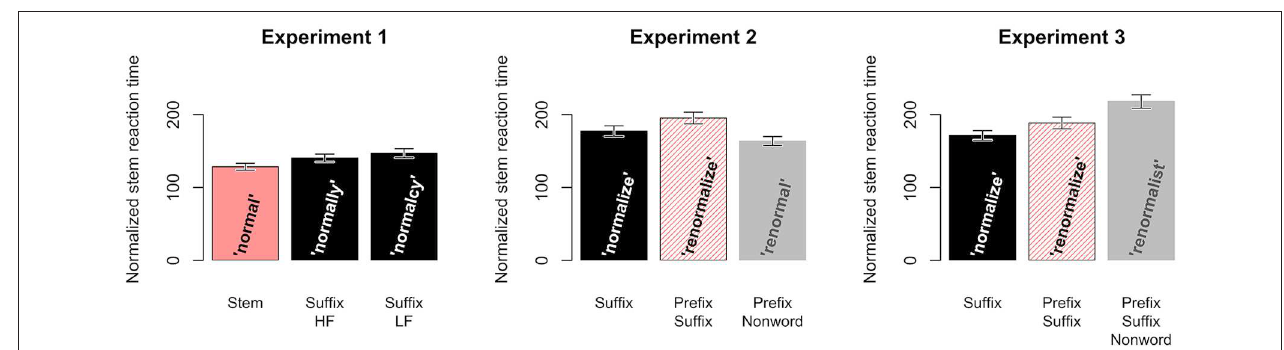
FIGURE 5 | Mean ( ± 1 SE) of the normalized stem latencies in Experiments 1, 2, and 3.